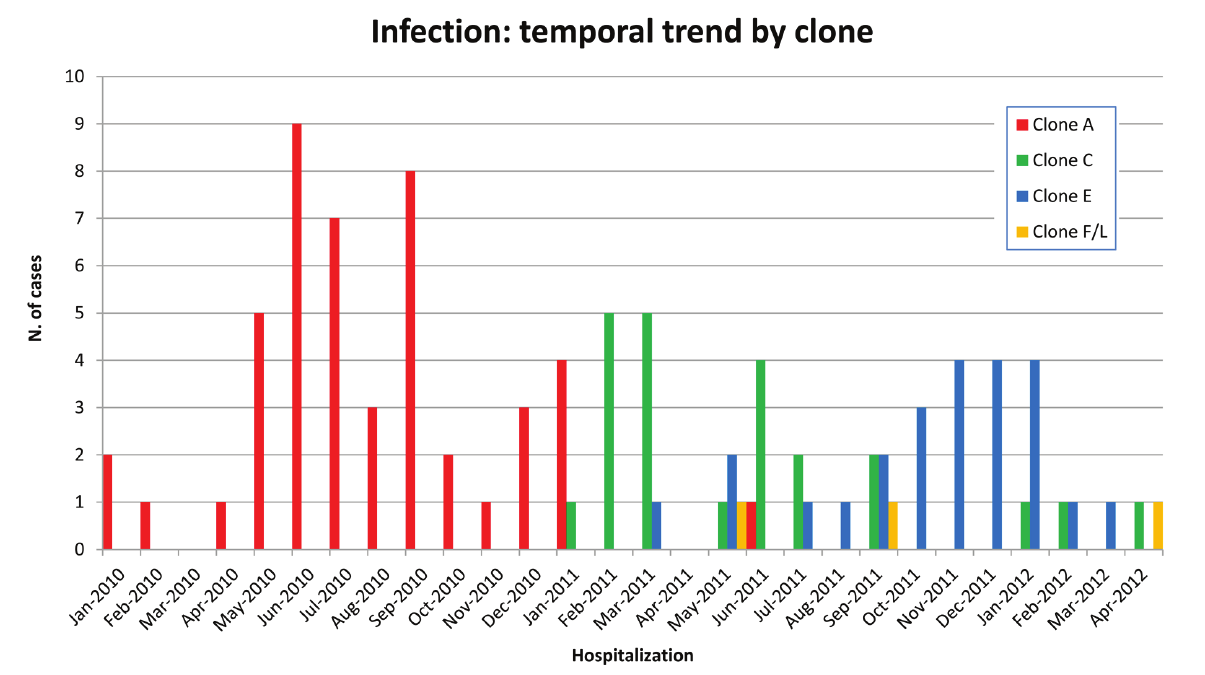
Figure 2. Number of KPC- Kp infected patients, identified by their KPC-clone, at the San Gerardo Hospital (a university public institution for adult and pediatric patients) in Monza, Italy since January 2010 (index case) and April 2012.